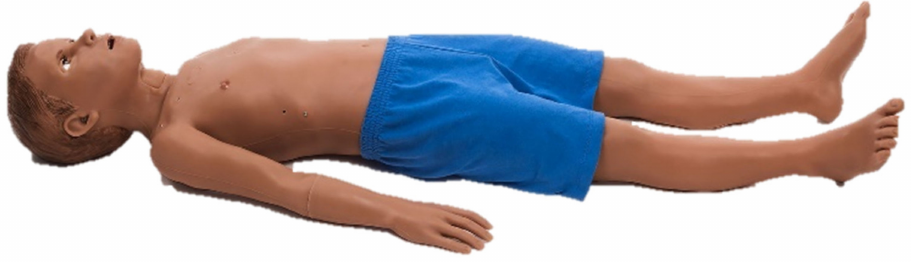
Figure 12. Hal pediatric nursing simulator